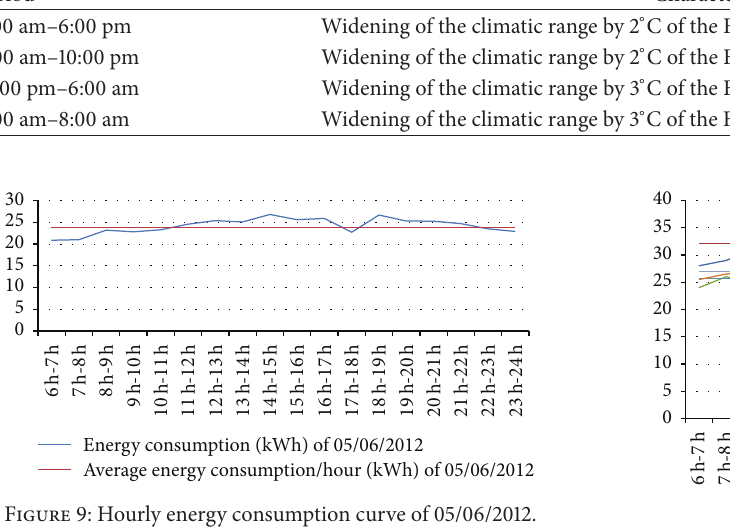
Table 6: Proposal of energy savings on the lighting aspect and air conditioning of the CRTV Maroua site. Period Characteristics of the site